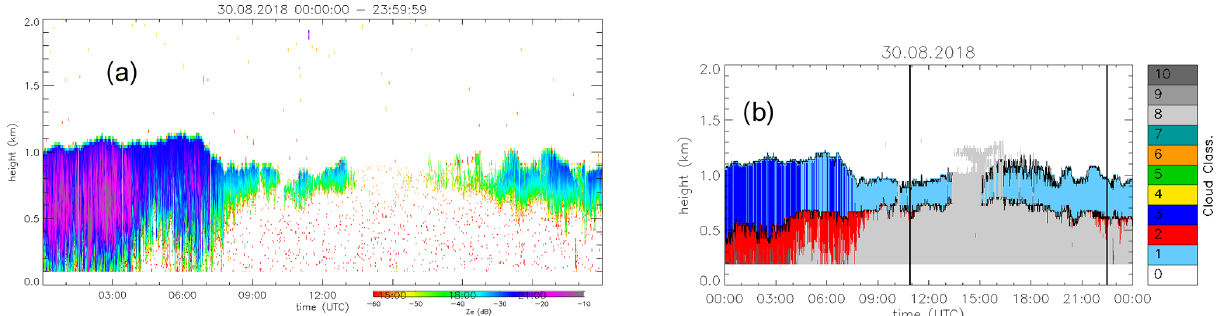
Figure A3. Example data from 30 August 2018. (a) Radar reflectivity Ze from cloud radar. (b) Cloudnet classification with classes clear sky (0, white), cloud droplets only (1, light blue), drizzle or rain (2, red), drizzle or rain and cloud droplets (3, dark blue) and aerosol (8, light gray). Thin black line indicates cloud base and cloud top. Vertical lines indicate the times of sunrise and